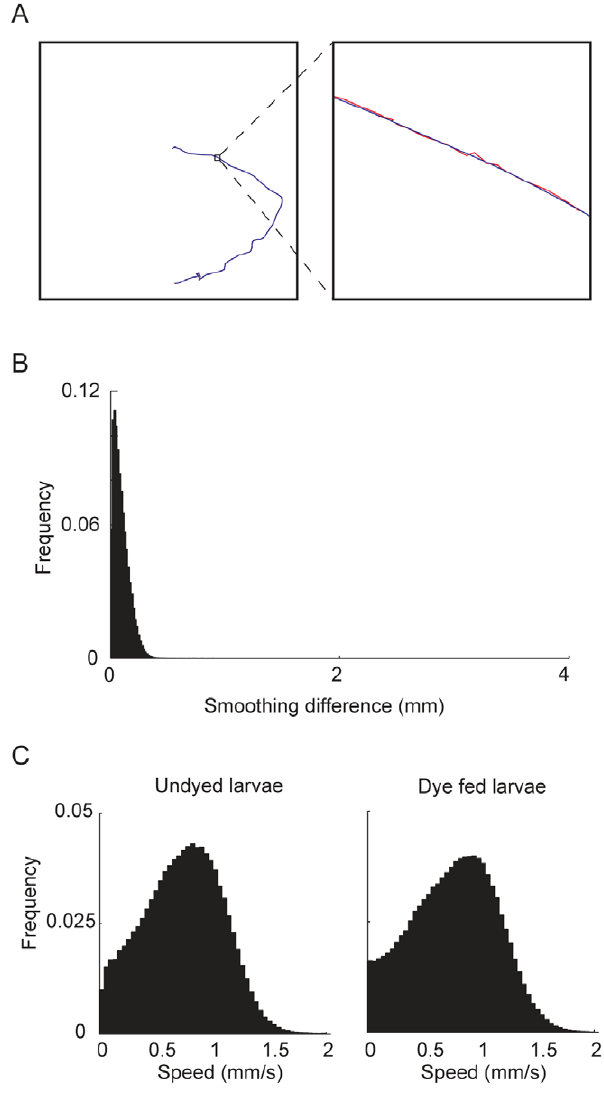
Figure 5. Extraction of locomotion parameters from tracks. A. We employed a Gaussian smoothing algorithm to the tracks. Red: original track, blue: smoothed track. B. The Gaussian smoothing did not introduce major differences from original tracks. Greater than 90% of differences were less than 200 m m. C. The speed distributions were not noticeably different between undyed and dye fed larvae (100 larvae for each distribution). To generate the distribution we calculated the instantaneous speed for each point on the smoothed track and plotted the distribution of all the speeds.